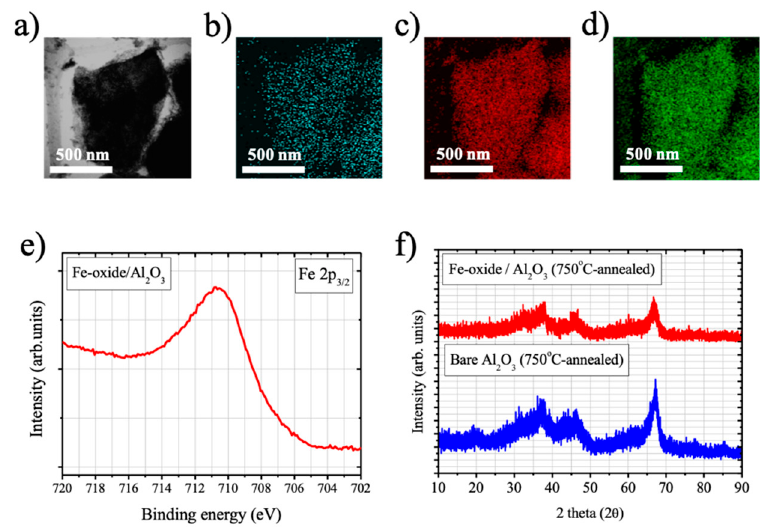
Figure 1. ( a ) Scanning transmission electron microscopy (STEM) image of Fe-oxide / Al 2 O 3 sample and scanning transmission electron microscopy-energy dispersive spectroscopy (STEM-EDS) mapping images of ( b ) Fe, ( c ) Al, and ( d ) O of Fe-oxide / Al 2 O 3 sample are displayed. STEM image and EDS mapping images were taken at same position of Fe-oxide / Al 2 O 3 sample. ( e ) Fe 2p 3 / 2 core-level X-ray photoelectron spectrum (XPS) spectrum of Fe-oxide / Al 2 O 3 is shown. ( f ) XRD patterns of bare Al 2 O 3 and Fe-oxide / Al 2 O 3 are shown.